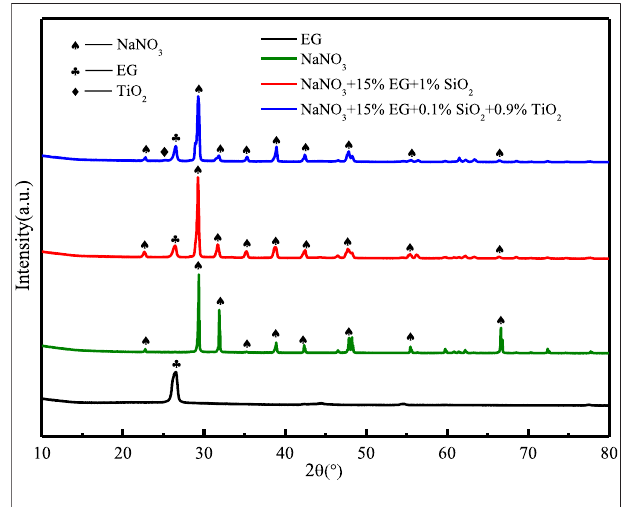
FIGURE 4 | XRD patterns of EG, NaNO 3 and its